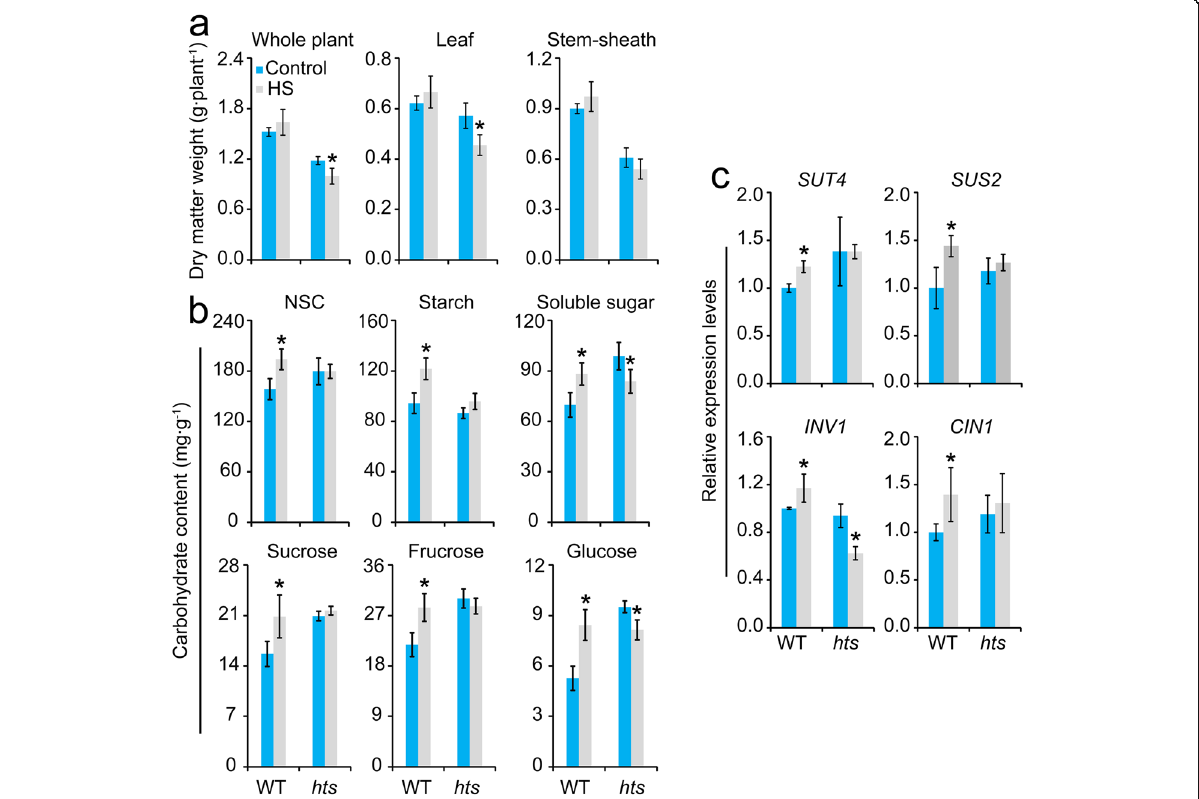
Fig. 2 Effect of heat stress on assimilate accumulation and distribution in rice plants under heat stress. a , Dry matter weight; b , Carbohydrate; c , Expression levels of SUT4 , SUS2 , CIN1 , and INV1 . Vertical bars denote standard deviations ( n = 3). A t -test was conducted to compare the difference between the control and heat stressed groups within a cultivar on the same day. * denotes P <